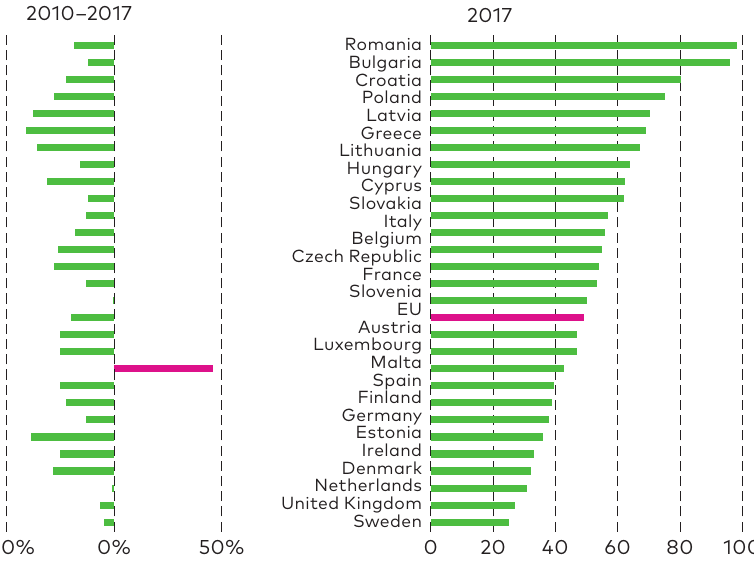
Figure 2. Road deaths per million inhabitants in 2017 and changes from